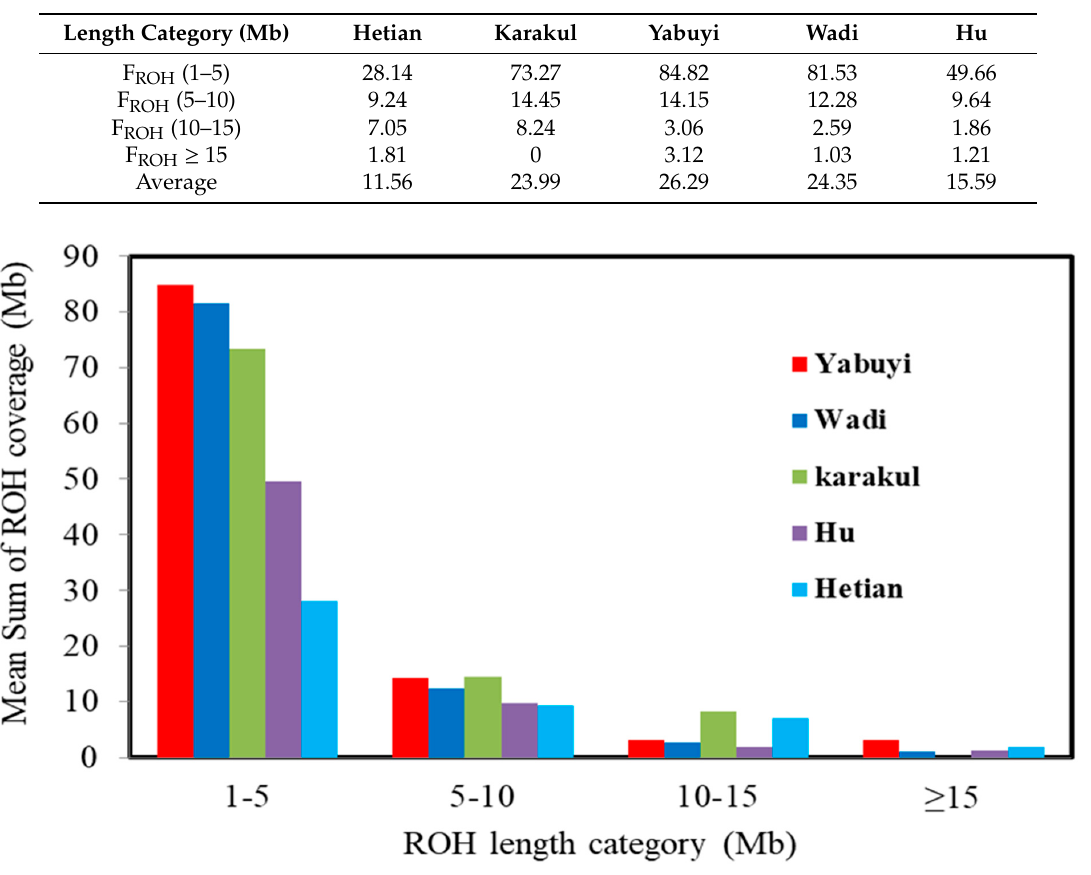
Figure 2. Genome-wide distribution of the mean sum of F ( ROH ) coverage di ff erent length categories per breed across five Chinese breeds. For each animal, within each ROH length category, ROH was summed up and then averaged per population .